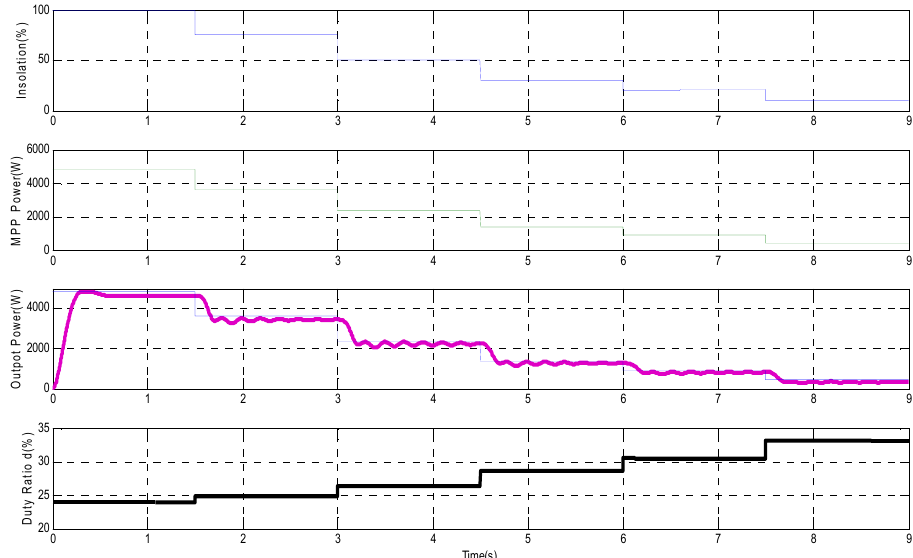
Figure 12. The MPP power, output power, and boost converter duty ratio ( d ) for the proposed system at step insolation changes.